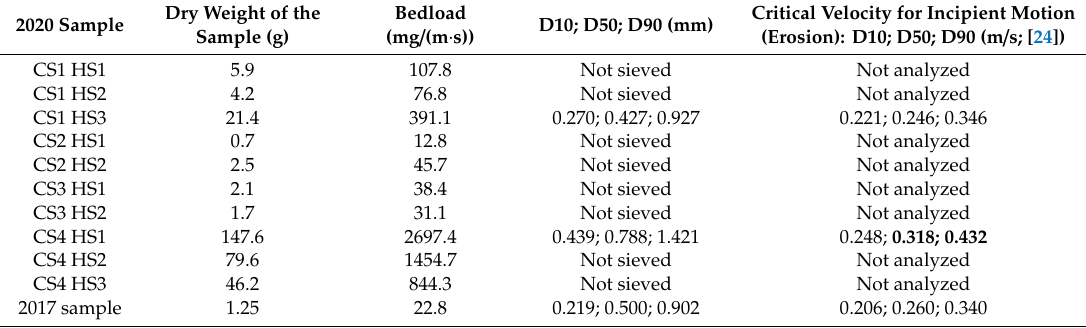
Table 4. The bedload transport amount and the grain sizes of 6 February 2020. The bolded critical velocities were compared against the near-bed streamwise velocities of the